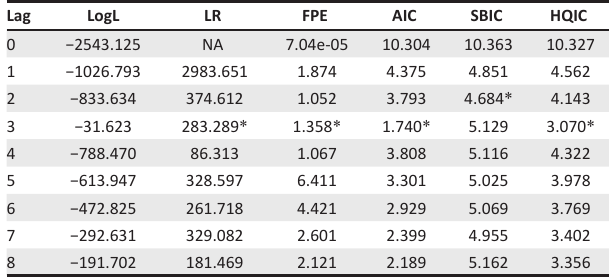
TABLE 2: Lag length determination and selection for the Panel Autoregressive Distributed Lag model. Lag LogL